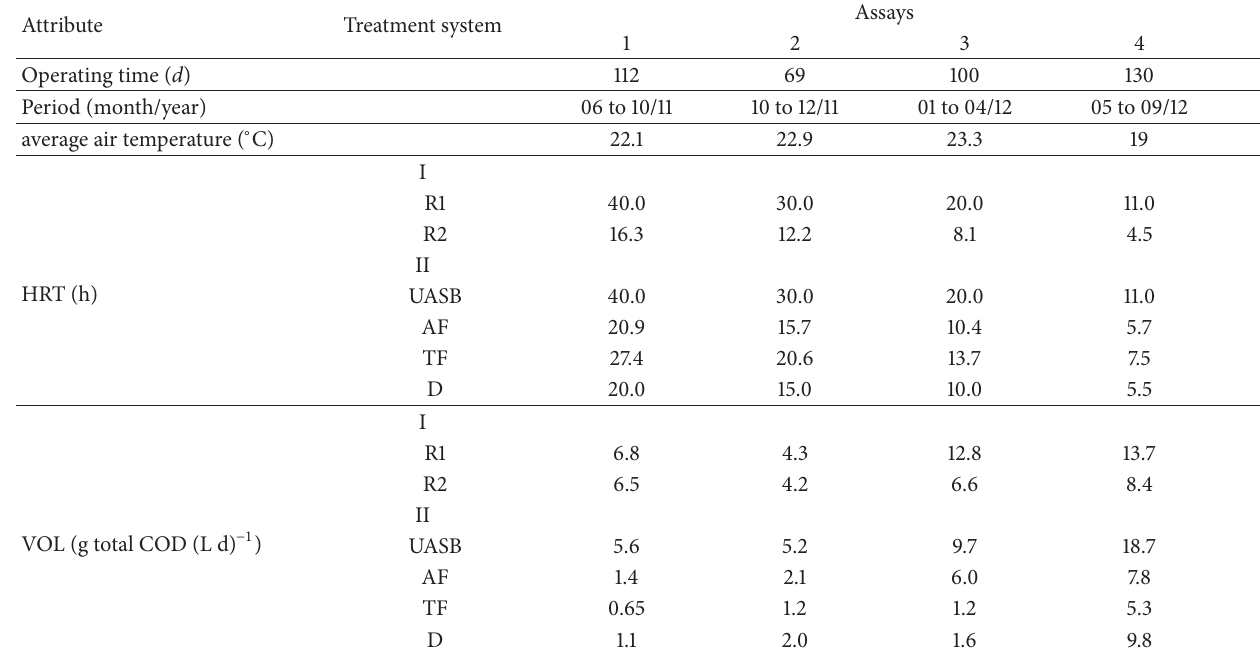
Table 1: Operating time, average air temperature, hydraulic retention time (HRT), and volumetric organic loading (VOL), applied on the UASB reactors (R1 and R2) of treatment system I and in the UASB reactor (R1), anaerobic filter (AF), trickling filter (TF), and decanter of anaerobic treatment system II, in assays 1 to